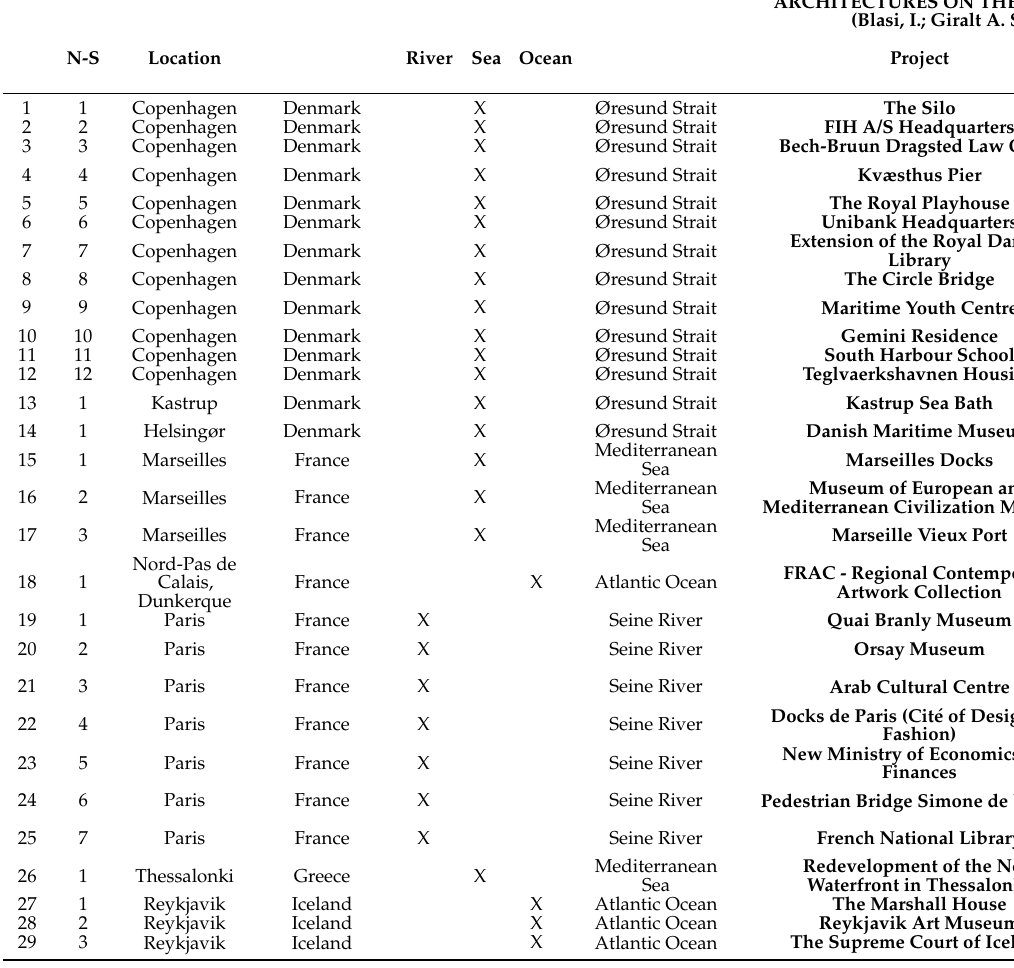
Table 2. Matrix parameters for the correlation. Authors’s Edition. Source Data: [55]. ARCHITECTURES ON THE WATERFRONT (Blasi, I.; Giralt A. S.;